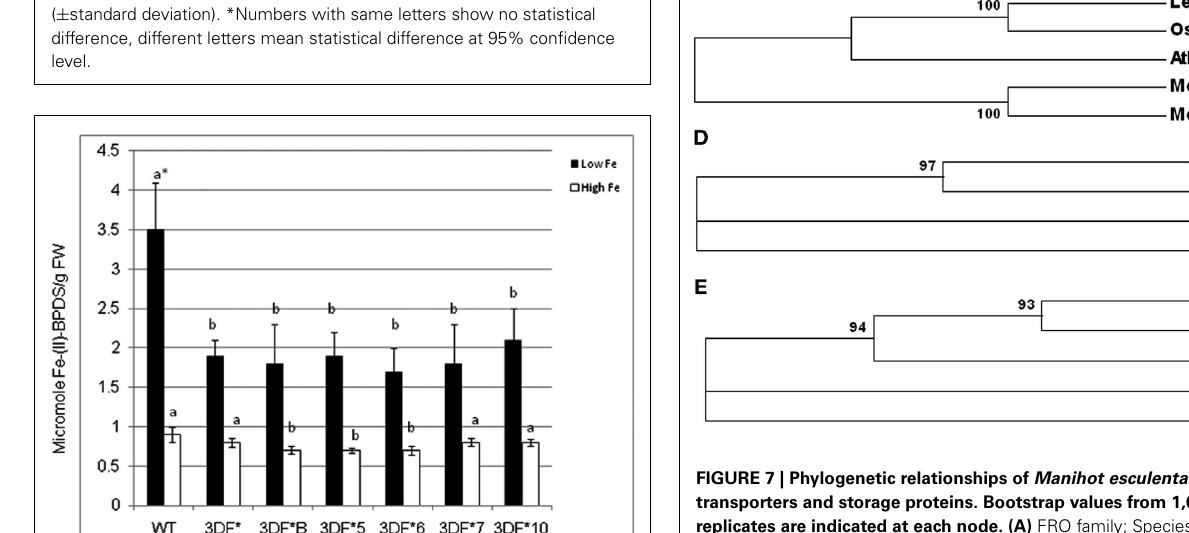
FIGURE 6 | Ferric chelate reductase activity of FEA1 transgenic and wild-type cassava plants. Stem cuttings from in vitro grown transgenic (3DF*, 3DF*B, 3DF*5, 3DF*6, 3DF*7, and 3DF*10) cassava and wild-type cassava were grown in MS media salts supplemented with 20% (w/v) sucrose for 4weeks. Afterward, the plants were transferred to liquid MS media containing either 25 or 5 µ M Fe(III)-EDTA for 2days.White bars represent high Fe and black bars represent low Fe treatment. *Numbers with same letters show no statistical difference, different letters mean statistical difference at 95% confidence level.